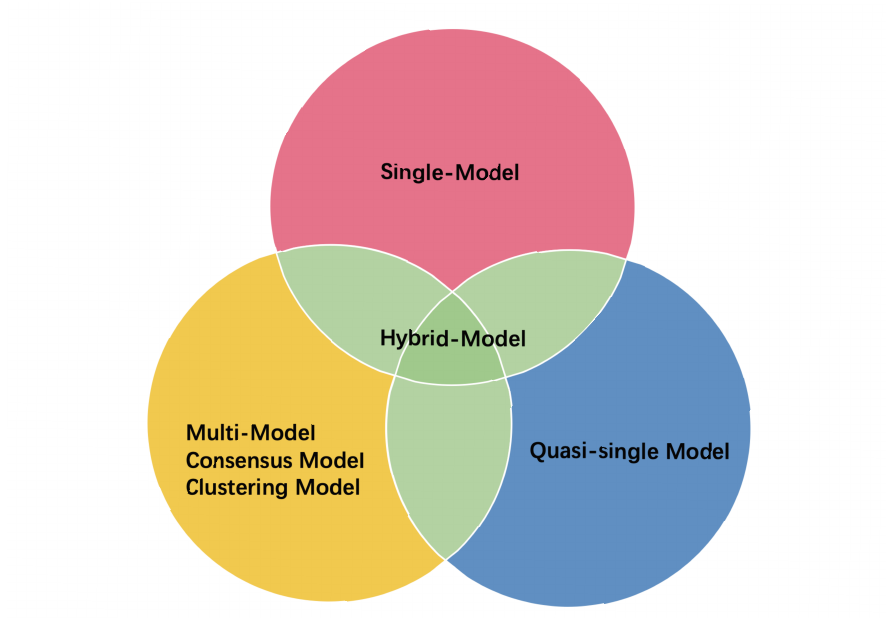
Figure 1. Four major approaches in the quality assessment of protein models: Single-model, multi-model, quasi-single model, and hybrid-model approaches. The hybrid-model methods combine selected models based on different